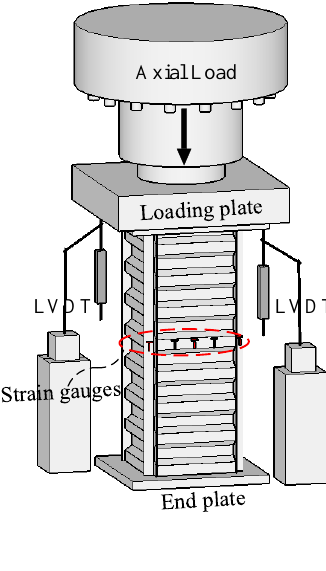
Figure 5. Failure modes of specimens.